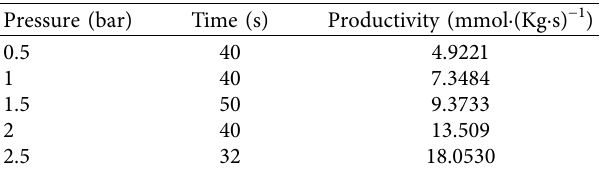
Figure 6: Effect of feed pressure on the productivity at 6L · min − 1 and 16 cm height of packing. Table 6: Data of effect of feed pressure on the productivity at 6 L · min − 1 and 16 cm height of packing.